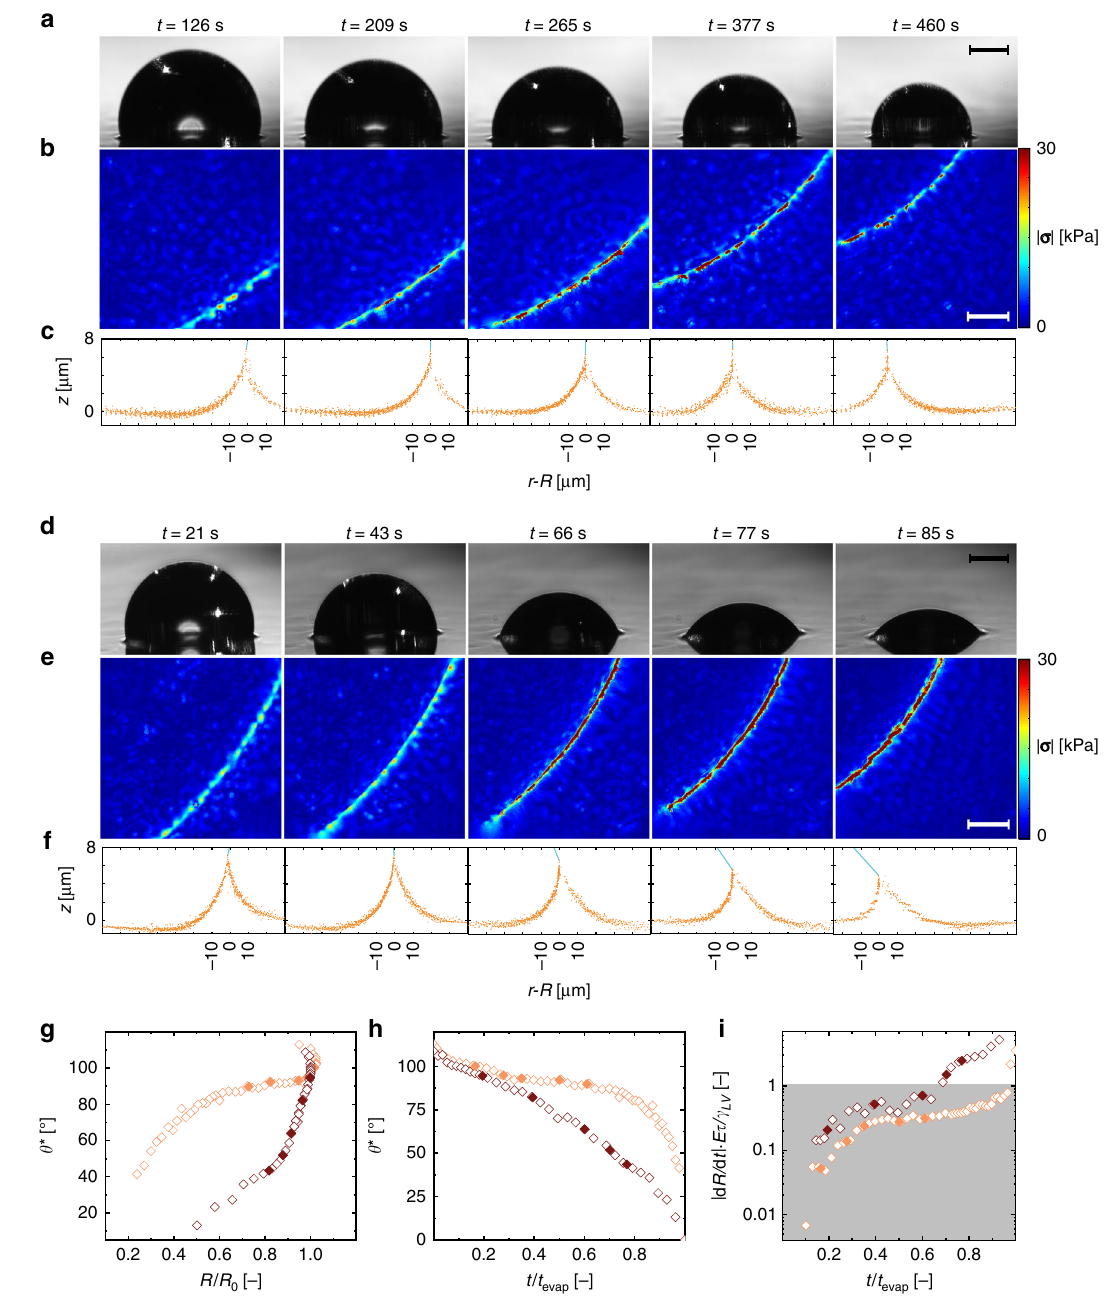
Fig. 3 Characterizing the effects of humidity and compliance on droplet de-wetting with 4D confocal reference-free traction force microscopy. a Time series of the macroscopic side-view showing a droplet slowly evaporating ( rH = 90%, T = 24 °C, V placed = 67 nL) from a compliant solid (Silicone CY 52 – 276 9:10), with b simultaneous stress vector fi eld magnitude at the contact line and, c simultaneous mesoscopic shape of the wetting ridge. Blue lines represent liquid – vapor interface. d Time series of the macroscopic side-view showing a droplet quickly evaporating ( rH = 15%, T = 24 °C, V placed = 49 nL) from a compliant solid (Silicone CY 52 – 276 9:10), with e simultaneous stress vector fi eld magnitude at the contact line and f simultaneous mesoscopic shape of the wetting ridge. Blue lines represent liquid – vapor interface. g Plot of θ * vs. R / R 0 of the droplets in ( a ) (orange) and ( d ) (red). The fi lled diamonds represent the time steps shown in ( a ) and ( d ). h θ * vs. t / t evap for the droplets in ( a ) (orange) and ( d ) (red). i Absolute normalized contact line speed, | dR / dt | E τ / γ LV , vs. t / t evap for the droplets in ( a ) (orange) and ( d ) (red). Scale bars: a , d , 150 µ m, b , e , 20 µ m. Source data are provided as a Source Data fi le for ( c , f – i τ (characteristic substrate relaxation time). We determined τ as γ LV / E , where γ LV is the liquid surface tension. Substituting experimentally by performing step-strain tests and fi tting a gen- appropriate values yields γ LV /( E τ ) = 0.98 µm s − 1 ( γ LV = 71.97 eralized Maxwell solid model with two elements to the data (see mN m − 1 , E = 12.6 kPa, τ = 5.8 s). During rapid evaporation, dR / dt becomes comparable in magnitude to, and at late times, Methods and Supplementary Figs. 4 – 9 for measurements of τ and even exceeds γ LV /( E τ ). At these times, we also observe relatively E for the materials used in this study). The typical length scale of substrate deformation was de fi ned according to the literature 30,36 large surface stresses at the contact line and asymmetric wetting